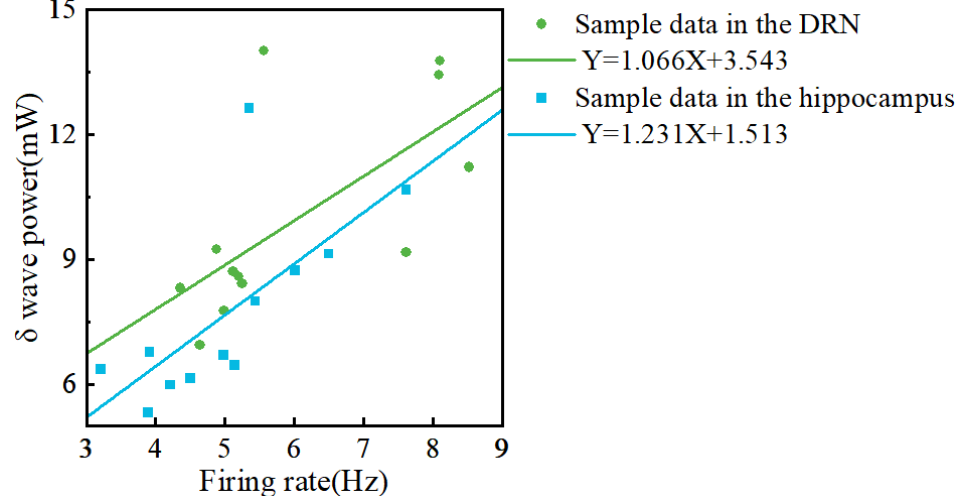
Figure 10. The relationship between neuronal firing rate and δ wave power in the dorsal raphe nucleus (DRN) and hippocampus. X: Firing rate; Y: δ wave power. The green line is the fitted line for the DRN data. The blue line is the fitted line for the hippocampal data.